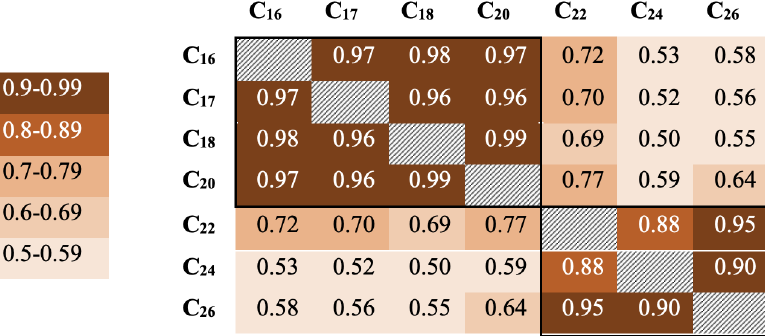
Figure 3. R 2 values for fatty acid concentrations throughout core DTGC2011. Values are colour-coded according to the key on the left. The black border denotes correlations within each group.